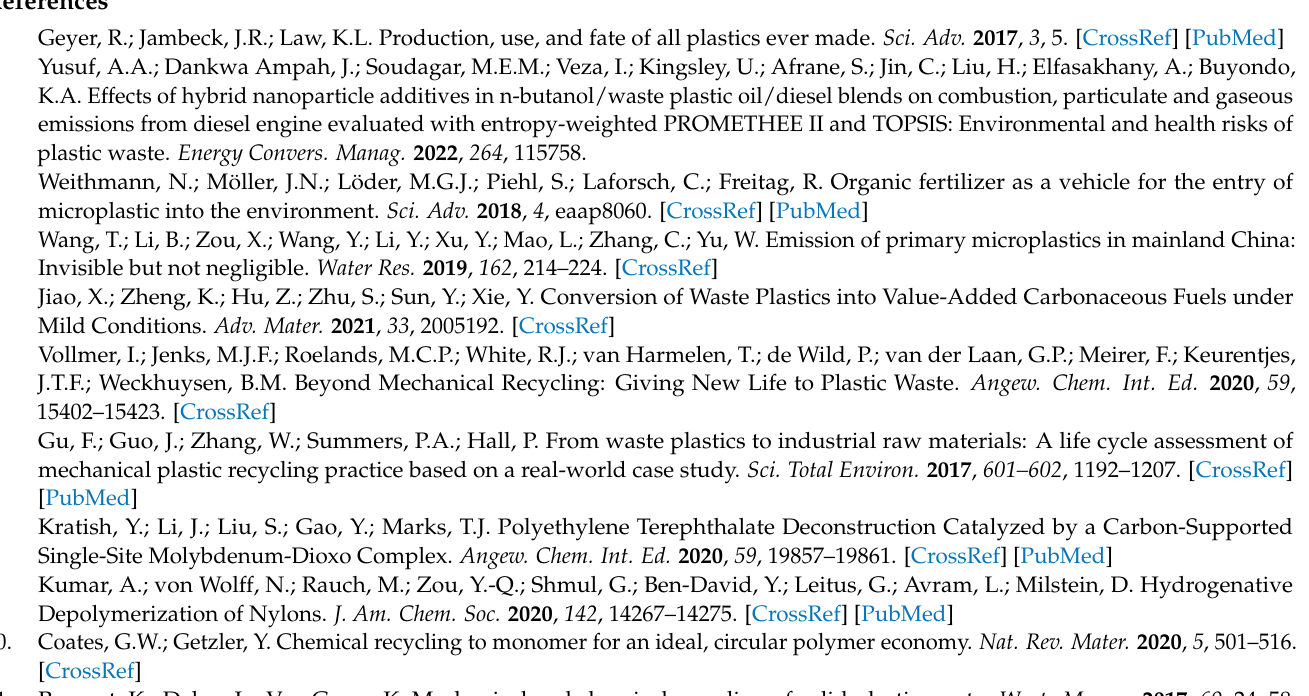
vs. time curves of different pressure experiments (listed in Table 1). Figure S2. GC-MS chromatograms of the recovered oil samples from different pressure experiments (listed in Table 1). Figure S3. 1H NMR spectra (red lines) and 13C NMR spectra (bule lines) of the oil products obtained from different pressure experiments (listed in Table 1). * and # indicate the solvent (chloroform-D) and TMS, respec- tively. Figure S4. GC-MS chromatograms of the recovered oil samples from different atmosphere experiments (listed in Table 1). Figure S5. Temperature and pressure vs. time curves of experiments of adding liquid hydrocarbon (1-hexene, 1-octene, 1-decene, 1-octene or xylene) (listed in Table 1). Figure S6. GC-MS chromatograms of the recovered liquid samples from experiments of adding liquid hydrocarbon (1-hexene, 1-octene, 1-decene, 1-octene or xylene) (listed in Table 1). Note that the peak of added liquid hydrocarbon is deducted. Table S1. Different proton types and shift region from 1 H NMR spectra of liquid